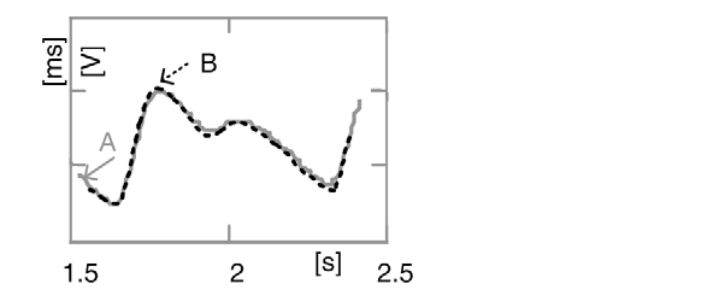
Figure 10. Comparison of obtained signals, ( A ) proposed, ( B ) Nonin’s system (8000AA sensor + OEM III Eval Kit +